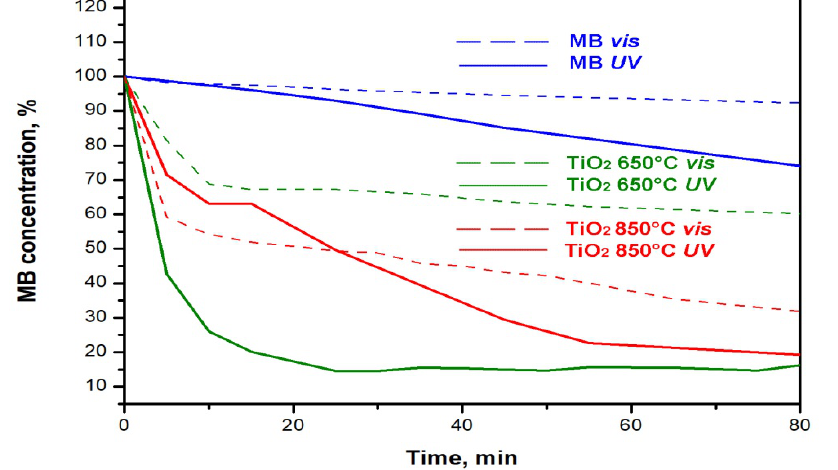
Figure 4. MB concentration decay in time in presence of 20 mg of TiO